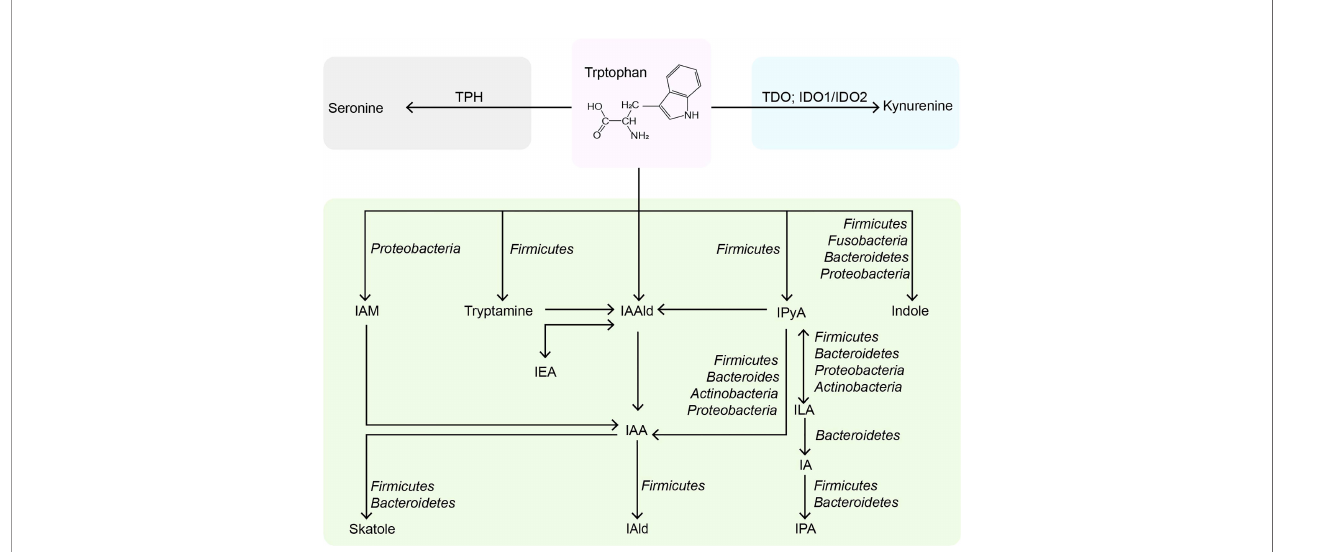
FIGURE 1 | Metabolic pathways of tryptophan in the intestine. TPH, tryptophan hydroxylase; TDO, tryptophan 2,3-dioxygenase; IDO, indoleamine 2,3- dioxygenases; IAM, indole-3-acetamine; IAAld, indole-3-acetaldehyde; IPyA, indole-3-pyruvate; IEA, indole-3-ethanol; IAA, indole-3-acetate; ILA, indole-3- lactate; IAld, indole-3-aldehyde; IA, indole-3-acrylate; IPA,